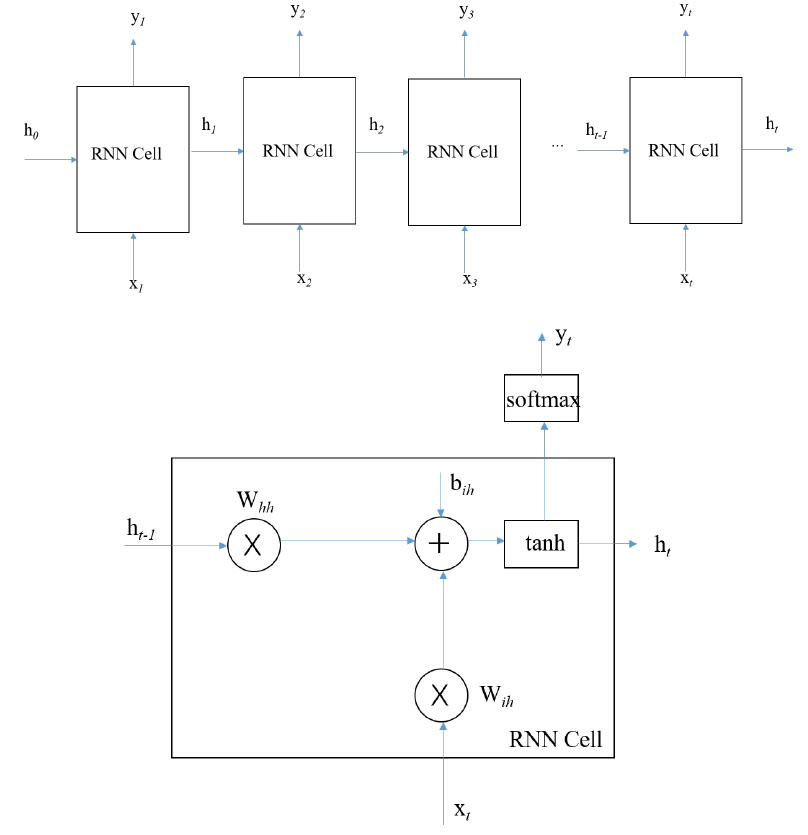
Figure 11. Details of the RNN layer and the RNN